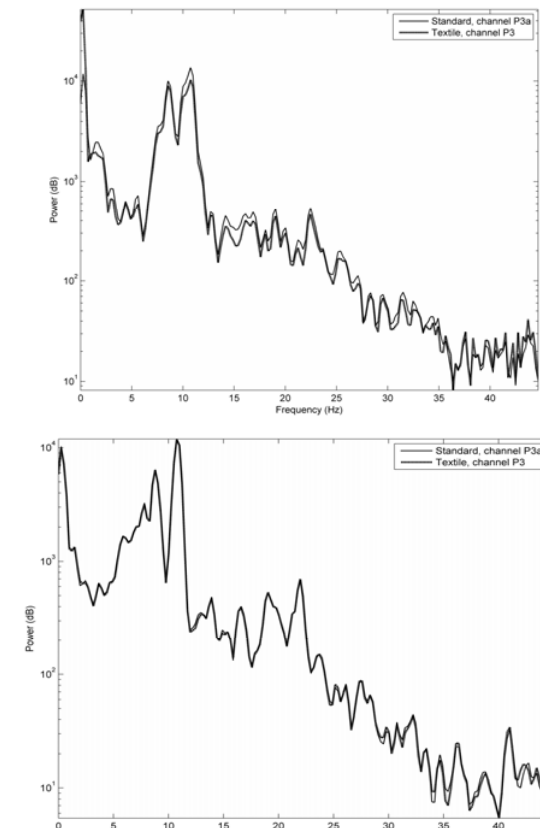
Figure 7. Frequency spectra for the 0–45 Hz spectrum, no filtering except detrending. Top left: Type I with gel, top right: Type I with NaCl, bottom left: Type II with gel, bottom right: Type II with NaCl.